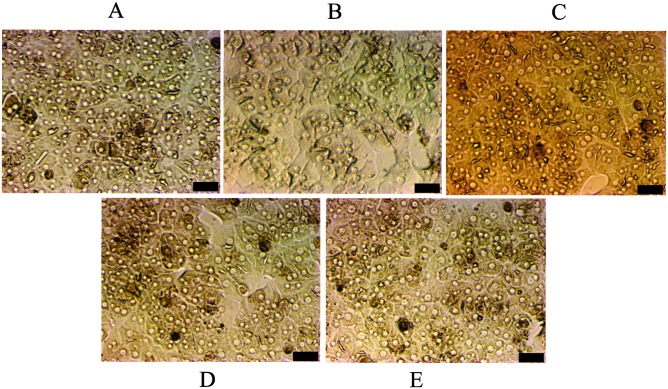
Effects of 1,3,4-thiadiazolium derivatives on hepatocytes morphology (the experimental conditions are described in the Materials and Methods section 2.6).Hepatocytes were incubated with the derivatives at 25 μM for 24 h. The images were obtained using inverted microscope. A: control (untreated cells); B-E: treatments by MI-D, MI-J, MI-4F and MI-2,4diF, respectively. The scale is indicated by black bars representing 50 μm. The photographs represent three different experiments in triplicate.